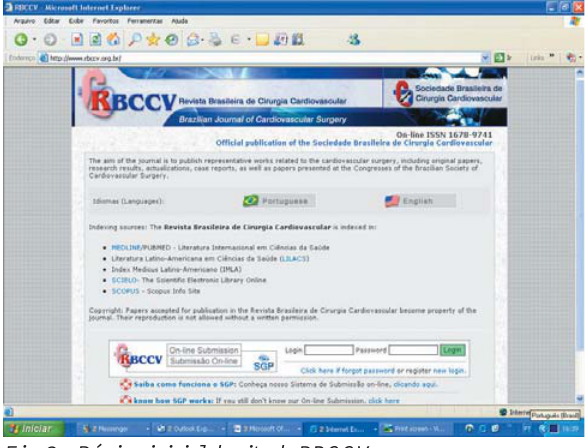
Fig. 3 – Página inicial do site da RBCCV